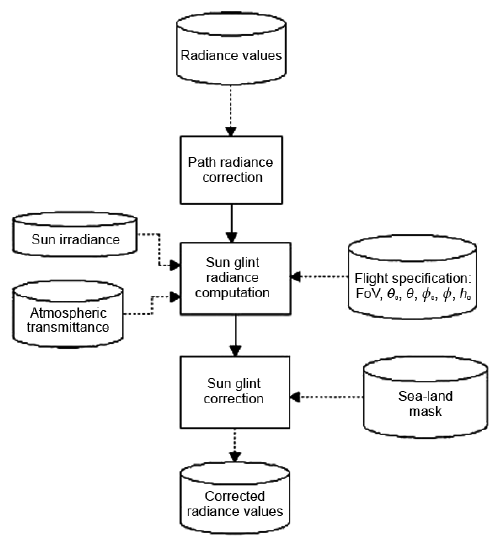
Fig. 6. Process chart of the sun glint correction.